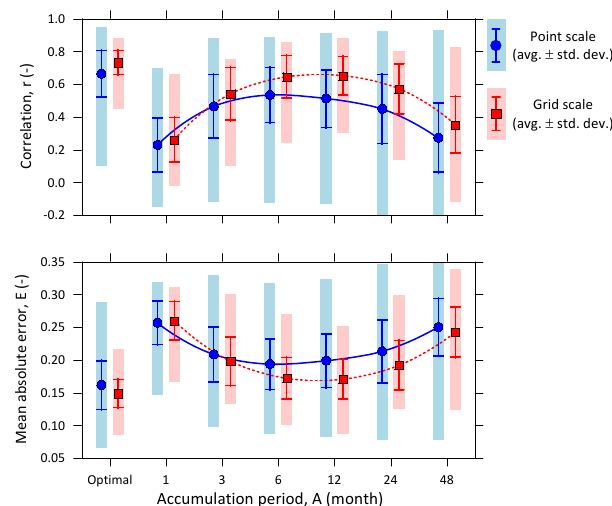
Figure 4. The correlation r (top) and the mean absolute error E (bottom) estimated between the SGI and SPI of the 1, 3, 6, 12, 24, and 48 months of uniform accumulations for the point and gridded data sets. Their respective maximum ( r m ) and minimum ( E m ) esti- mates corresponding to the optimal accumulation periods of the SPI are also shown in the leftmost of the panels. Summary statistics are provided as an average ± 1 standard deviation, and the entire range is depicted as filled bars in the